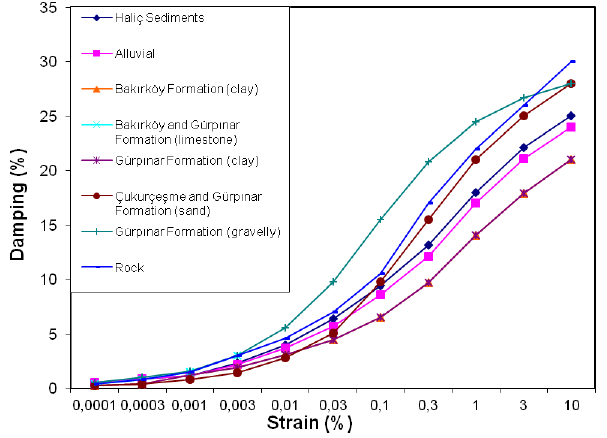
Figure 8. G/G max and Shear Strain releationships for all formations.